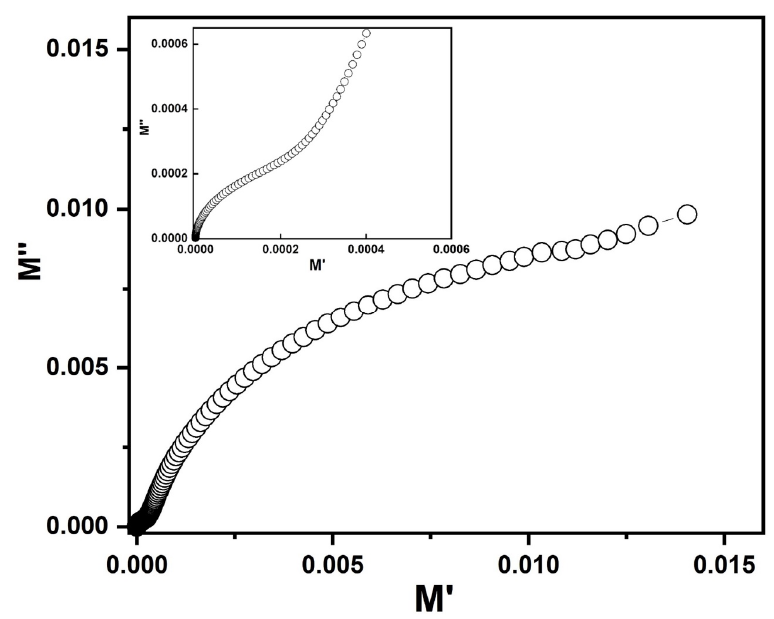
Figure 7. Complex modulus plane plot ( M ′′ vs. M ′) at room temperature for PbS.